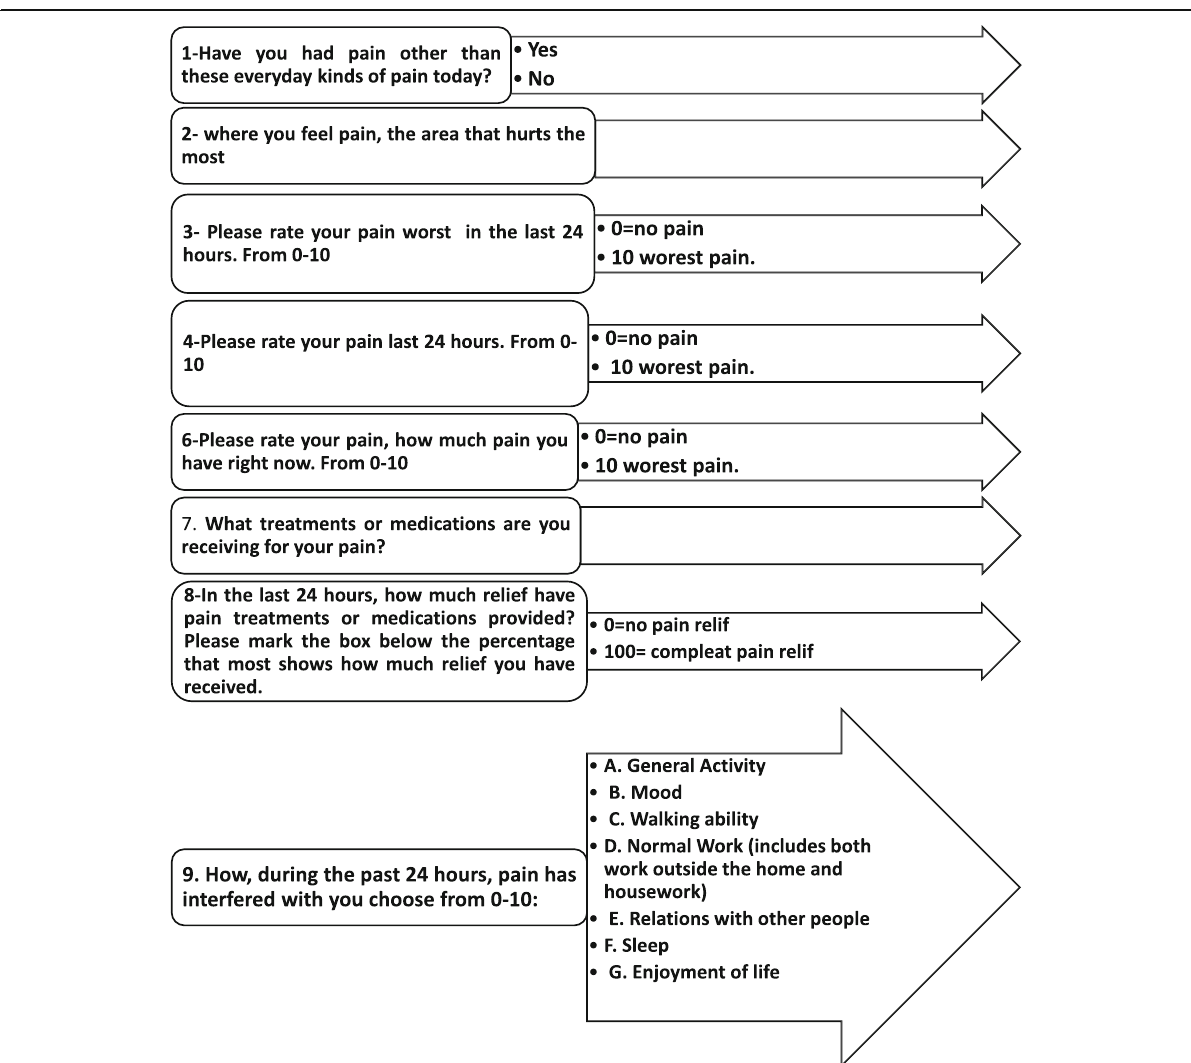
Fig. 1 Brief Pain Inventory short form (BPI-sf). Brief Pain Inventory questionnaire; a pain assessment tool that measures both the intensity of pain (sensory dimension) and interference of cancer pain in the patient ’ s life (reactive dimension). From the 1st – 6th question pain history, site, worst pain, least pain, average pain, and pain intensity right now utilizing numerical rating pain scale of 10. (Visual analogue score VAS). Pain severity score PSS was calculated by addition of the values of items (3 + 4 + 5 + 6) and then dividing by 4 this gives a severity score out of 10 (1 – 3 mild pain, 4 – 6 moderate pain, 7 – 10 sever pain). Item numbers 7and 8 described types of medications used for pain management and how much pain relief patients got in terms of percentage. Pain interference score PIS was calculated by adding the scores for questions (9A + 9B + 9C + 9D +